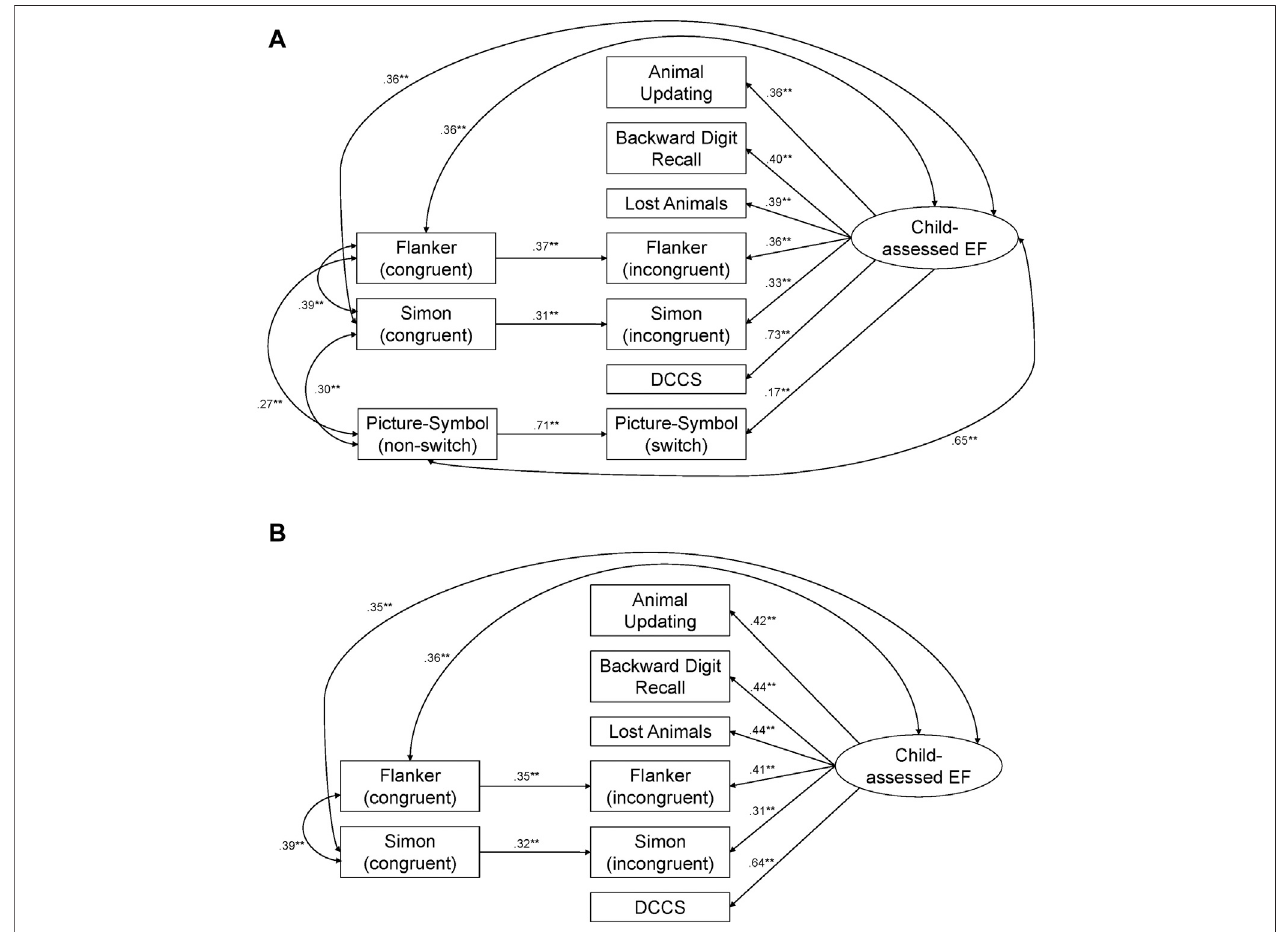
FIGURE 1 | Factor structure of child-assessed executive functioning (EF). The initial and fi nal factor structure is shown in (A) and (B) , respectively. All path coef fi cients are standardized estimates. ** p < 0.01.